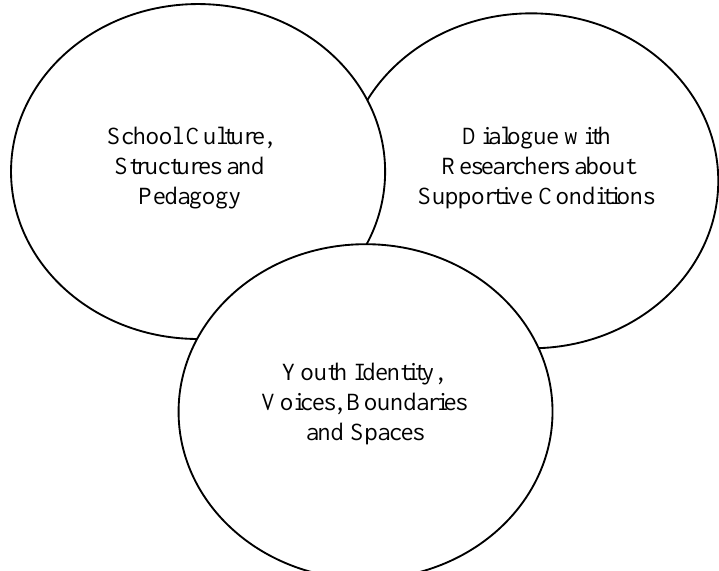
Figure 1. A heuristic for examining the complexity of early school